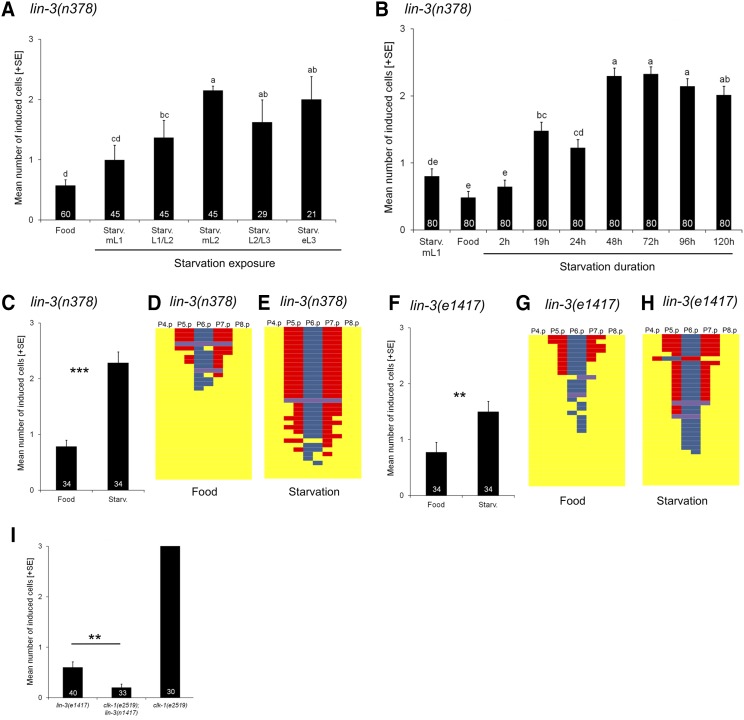
Quantifying starvation effects on vulval induction in lin-3/egf(rf) mutants. (A) Differences in vulval induction of lin-3(n378) animals exposed to starvation (48 hr) at different developmental stages. Starvation suppression of lin-3(n378) differed significantly between exposed developmental stages (ANOVA, F5,239 = 14.02, P < 0.0001), with strongest effects observed from mid L2 to early L3 stages. (B) Effects of starvation duration on vulval induction of lin-3(n378). Animals (age-synchronized by egg-laying windows) were exposed to starvation at the mid L2 stage for different time periods except for the first treatment where animals were starved in liquid (M9 buffer) for 12 hr directly after hatching (N = 80 per treatment). Starvation duration significantly affected levels of vulval induction (ANOVA, F5,239 = 14.02, P < 0.0001) with strongest suppression of lin-3(n378) at 48 to 120 hr of starvation. (C) Starvation (48 hr) significantly increased vulval induction of lin-3(n378) animals relative to control food conditions (ANOVA, F1,66 = 33.75, P < 0.0001). (D, E) Individual lin-3(n378) fate patterns of P4.p to P8.p in (D) food vs. (E) starvation conditions. (F) Starvation (48 hr) significantly increased vulval induction of lin-3(e1417) animals relative to control food conditions (ANOVA, F1,66 = 9.97, P = 0.0024). (G, H) Individual lin-3(e1417) fate patterns of P4.p to P8.p in (G) food vs. (H) starvation conditions. (I) clk-1(e2519); lin-3(e1417) animals did not show increased vulval induction (in food conditions) despite a strongly prolonged developmental time; rather, the double mutant exhibited a significantly reduced mean number of vulval cells compared to the single mutant lin-3(e1417) in standard food conditions (One-Way-ANOVA, F1,71 = 0.83, P = 0.0025). Values represented by bars (A,B,C,F) indicate the mean number of induced vulval cells, also referred to as the vulval index (WT = 3 cells induced). Values with different letters indicate significant differences (ANOVA, followed by Tukey’s HSD) (* P < 0.05, ** P < 0.01, *** P < 0.001, ns: non-significant). Numbers displayed in bars represent the number of individuals scored; error bars indicate ± 1 SEM. Vulval cell fate patterns of P4.p to P8.p (D,E,G,H) were, whenever feasible, separately inferred for Pn.pa and Pn.pp in cases of half-induced fates. Each line represents the vulval pattern of a single individual, and individuals are ordered from highest to lowest index of vulval induction. Color coding of vulval cell fates (1°: blue, 2°: red) and non-vulval cell fates (3°: yellow). Induced vulval cells that could not be clearly assigned to either a 1° or 2° fate are shown in purple.